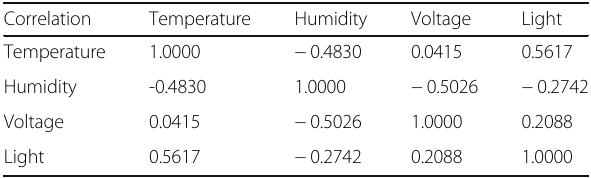
Table 1 Correlation coefficient of sensory data